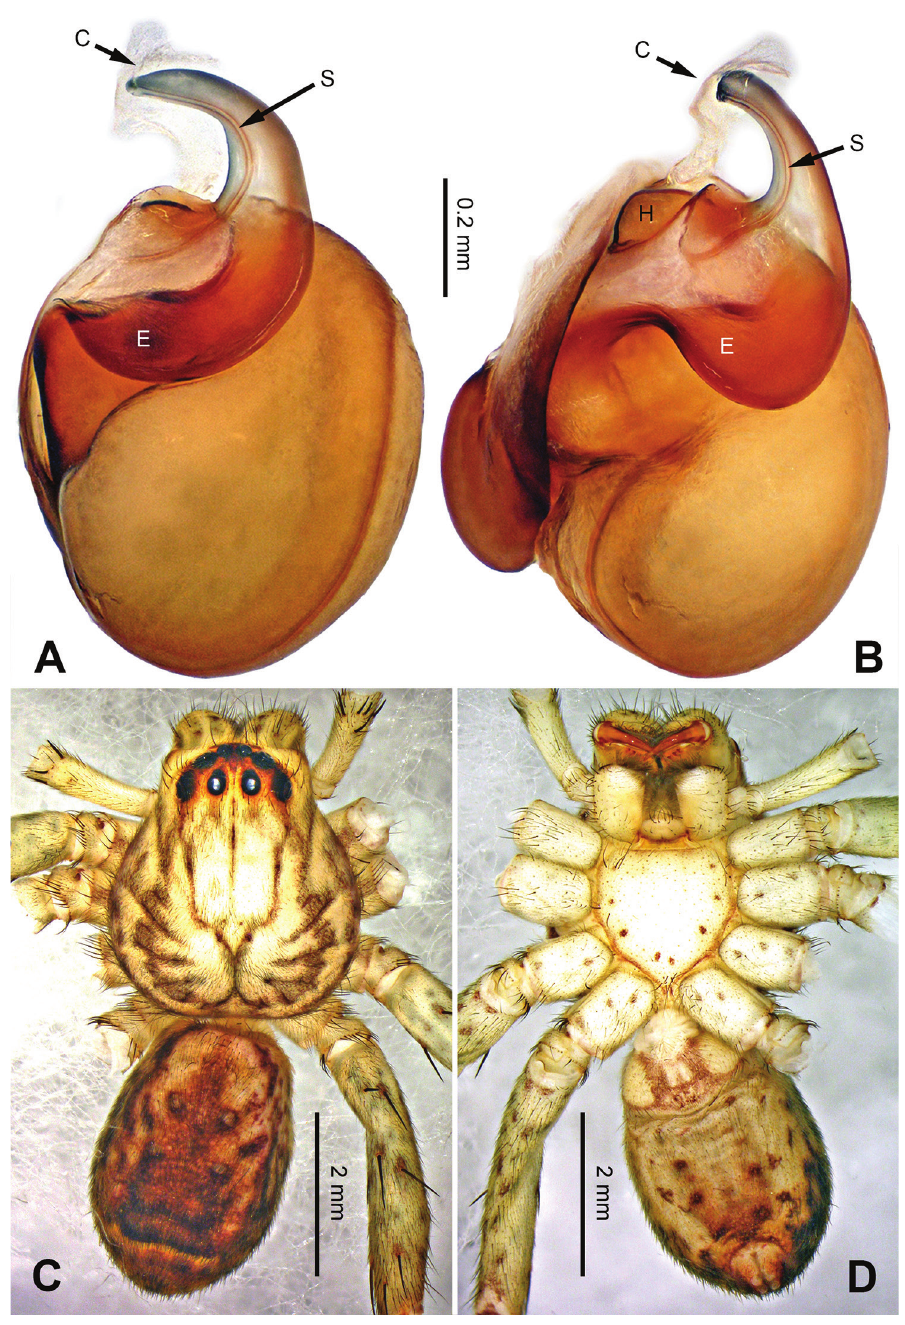
Figure 23. Pseudopoda shuo Zhao & Li, sp. n., male holotype. Right bulb horizontally flipped for the sake of comparison. A Bulb, ventral view B Bulb, dorsal view C Habitus, dorsal view D Habitus, ventral view. Scale bar equal for A, B